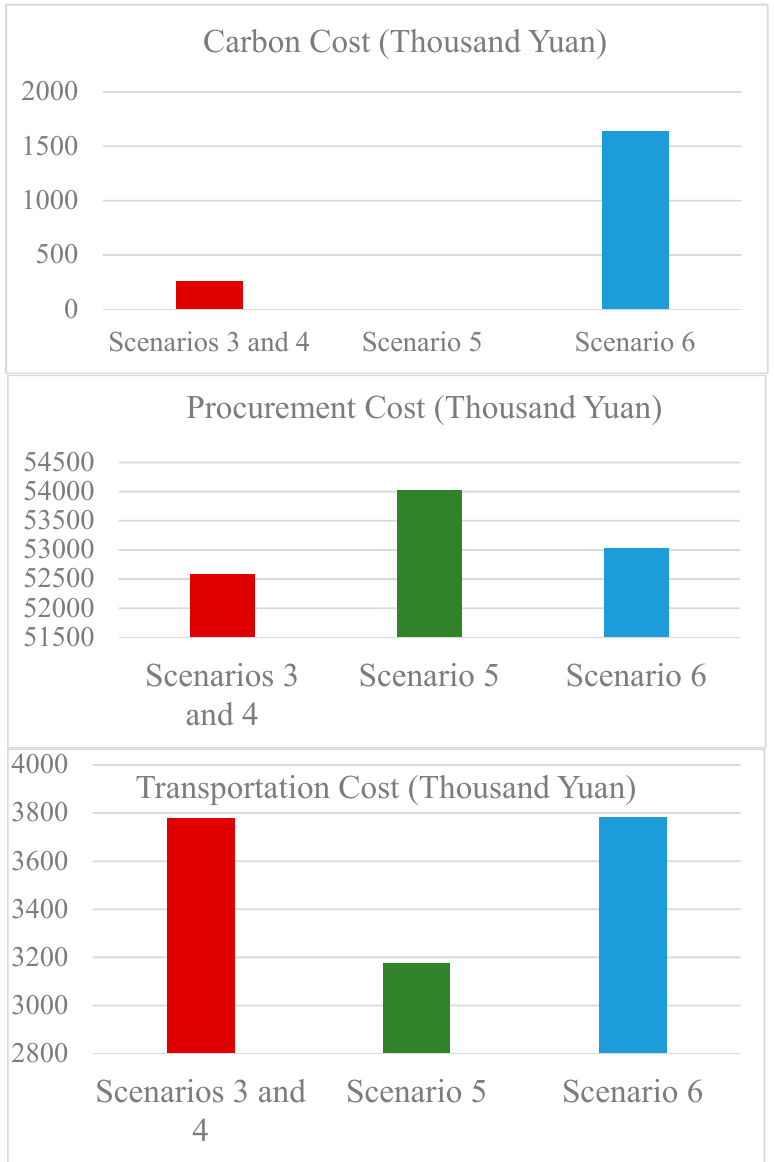
Figure 7. Comparison of the cost structures of different scenarios.